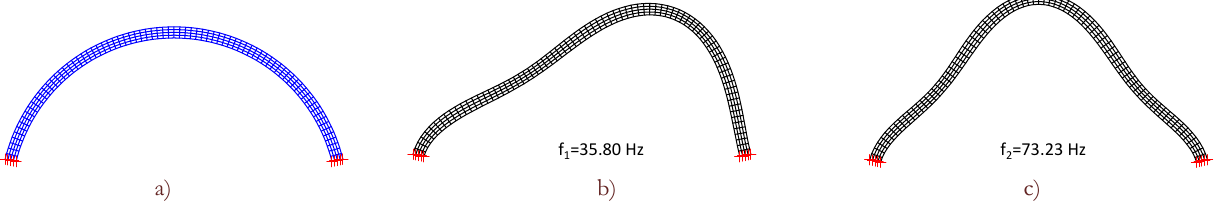
Figure 3: Finite element model of the masonry arch: a) mesh; b) mode shape and frequency for mode 1; mode shape and frequency for mode 2.